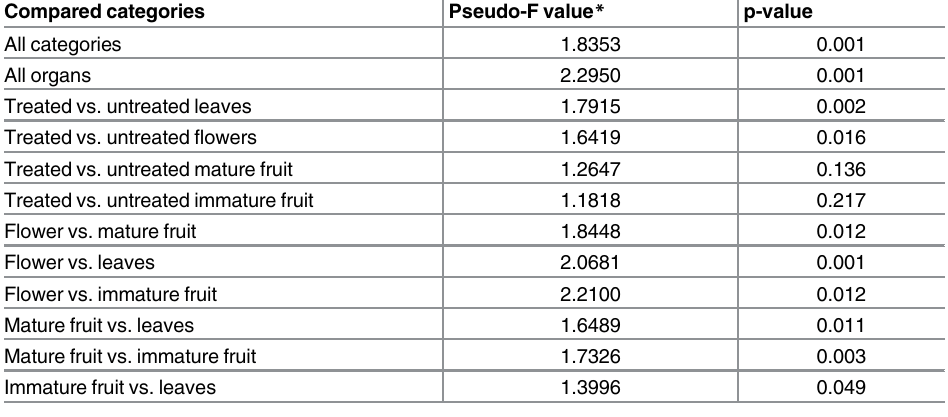
Table 3. Comparison between treated and untreated strawberry organs according to unweighted Uni- Frac metrics ( β -diversity). The significance was determined through 999 Monte Carlo permutations using the distance-based redundancy analysis (db-RDA). Sample groups were considered significantly different if the P value was (cid:1)